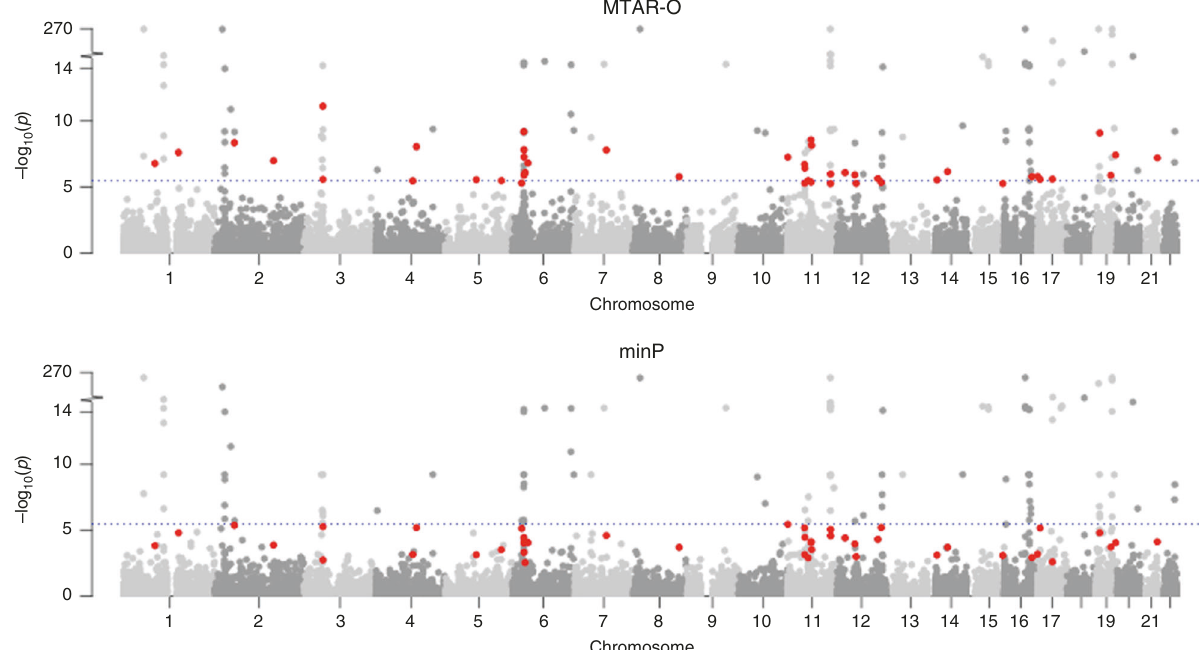
Fig. 3 Manhattan plots of MTAR-O and minP results in the GLGC data analysis. The horizontal line marks the genome-wide signi fi cance threshold (3.3 × 10 − 6 ). The 41 genes highlighted in red are those exclusively discovered by MTAR tests (MTAR-O, cMTAR, and iMTAR). The Manhattan plots for the other methods (cMTAR, iMTAR, and cctP) are shown in Supplementary Fig.